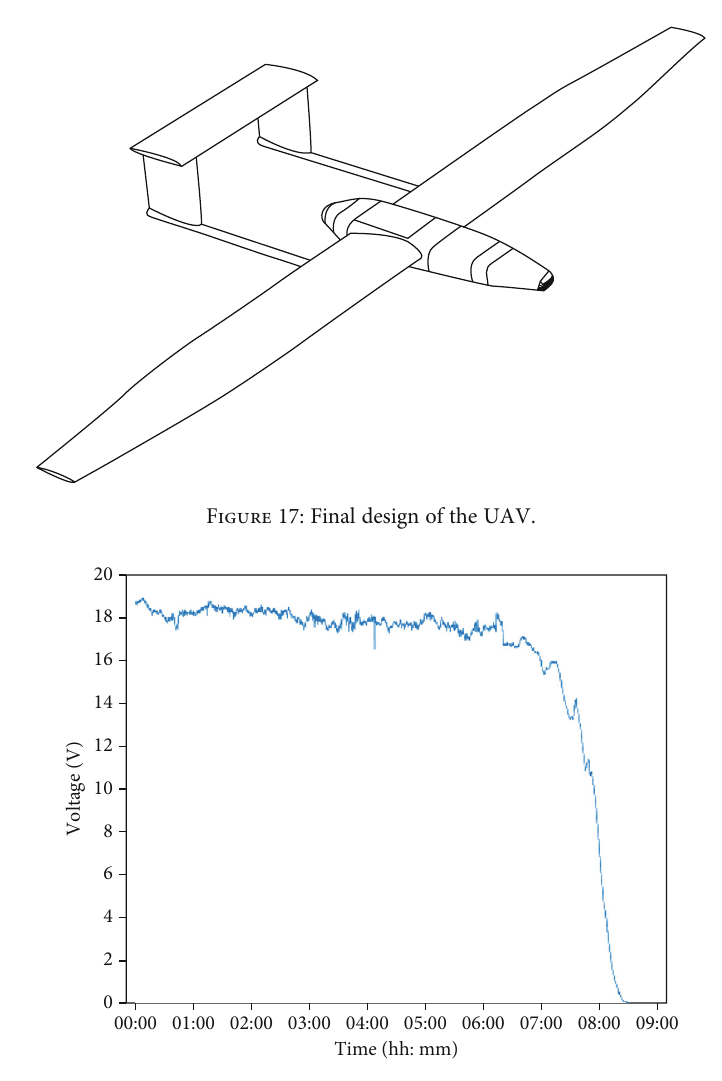
Figure 18: Voltage with respect to time of the solar cells.